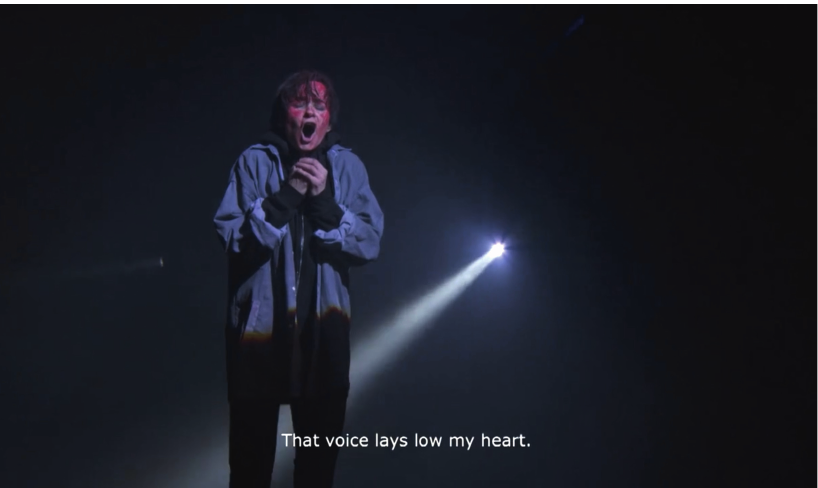
Fig. 5 Anna Goryachova/Sesto (act II, scene 10). Still frame from the streamed performance on GTG Digital (February 19,